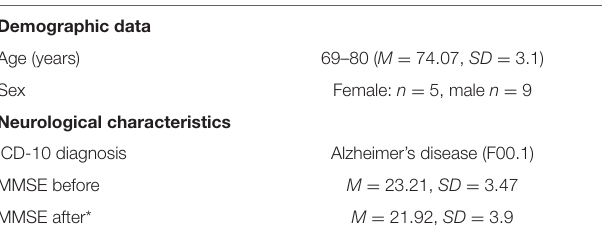
TABLE 1 | Demographic data and neurological characteristics.